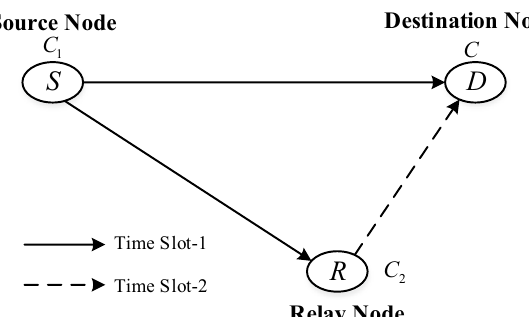
Fig. 1 General system model of distributed linear block codes. It requires two time slots to complete the whole communication transmission, where solid and dashed lines denote the first and second time slots, respectively. The source and relay nodes have linear block codes C 1 and C 2 , respectively, which are distributed to achieve coded cooperation. The resulted code at the destination is C = {| c 1 | c 2 | , c 1 ∈ C 1 , c 2 ∈ C 2 } . Since no additional information is generated at the relay (the information at the relay depends on the information at the source) in our proposed system model, the code C is a subcode of ¯ C = {| c 1 |¯ c 2 | , c 1 ∈ C 1 , ¯ c 2 ∈ C 2 } , where ¯ c 2 corresponds to the information independent on the information at the